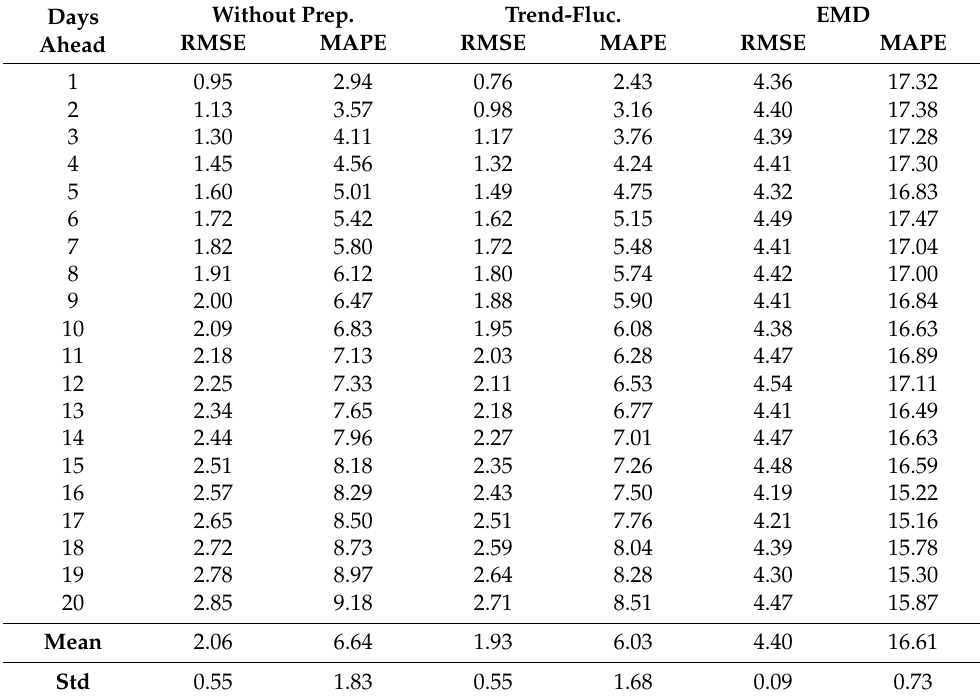
Table 6. Predictions with LSTM for the whole data set (2009–2020). 80% of them were used for training and 20% for validation. Data have been scaled with standardization for “Without Prep.” and “Trend-Fluc.” and with Min-Max for EMD. Without Prep. Days Ahead